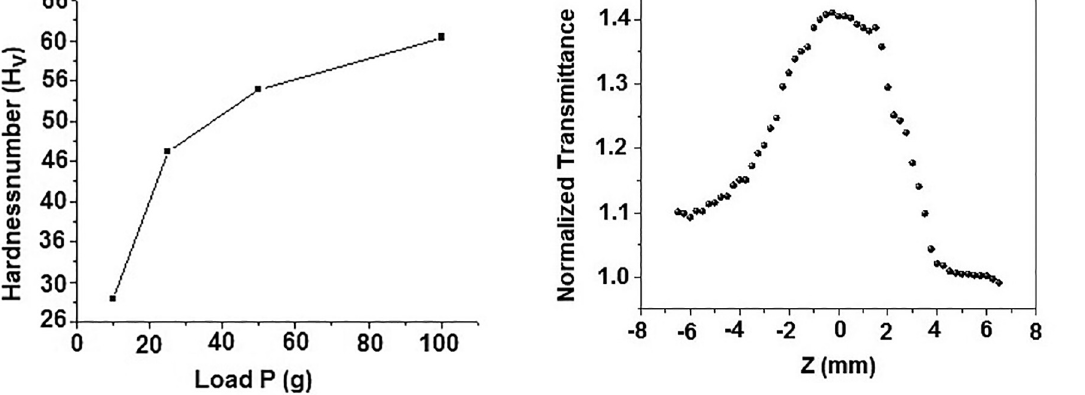
Figure 8: Z-scan open curvature of the 4BPTS.